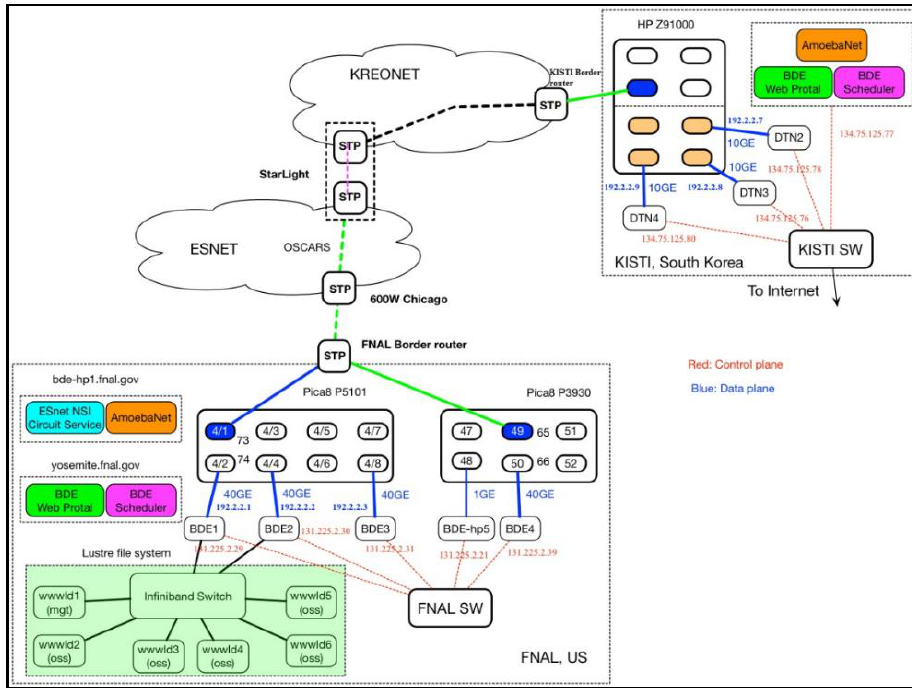
Figure 8. AmoebaNet’s cross Pacific experimental topology .